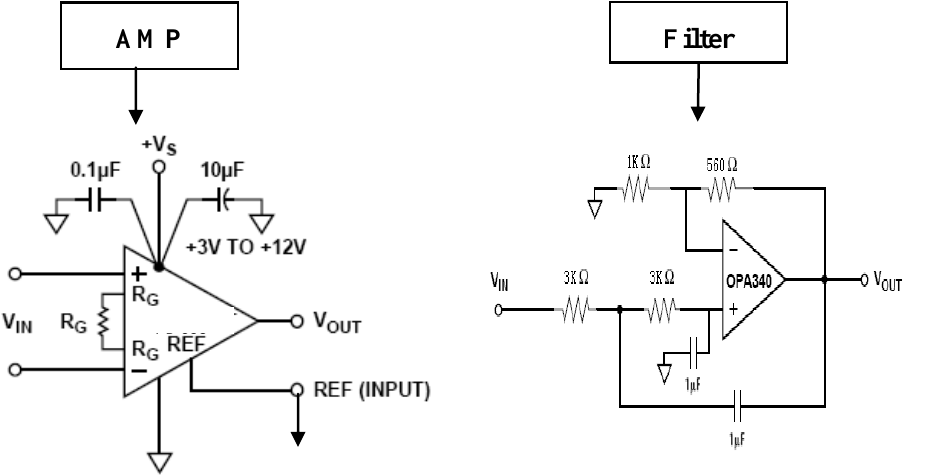
Figure 6. Circuit design of the amplifier and